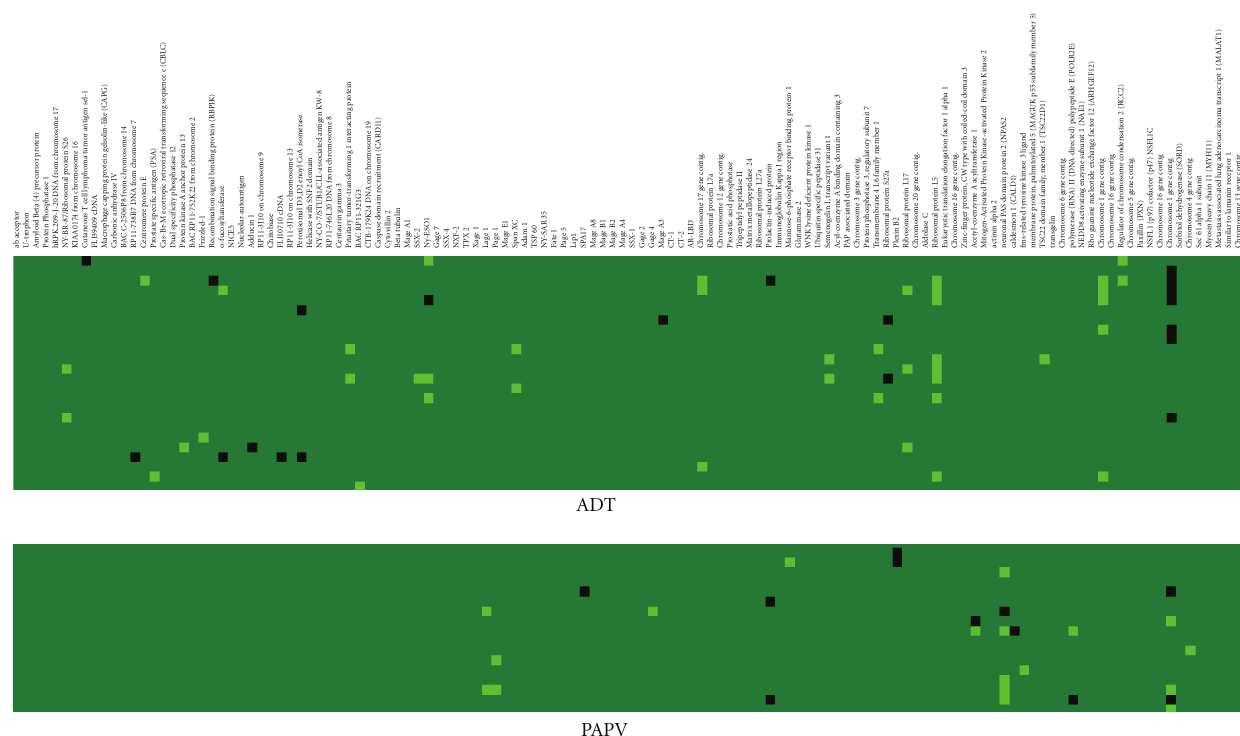
Figure 3: IgG responses to specific prostate-associated antigens are detectable several months after initiation of treatment with ADT or a PAP vaccine. Immunoblot analysis was performed with the same panel of antigens using sera from individual subjects for whom sera was available 12 months after beginning treatment with ADT (24 of the original 34) or the PAP vaccine (19 of the original 21). The heatmap similarly shows gain of response pretreatment to 12 months posttreatment (light green), loss of response following treatment (black), or no change in response (dark green) for all subjects (in rows) and all antigens (in